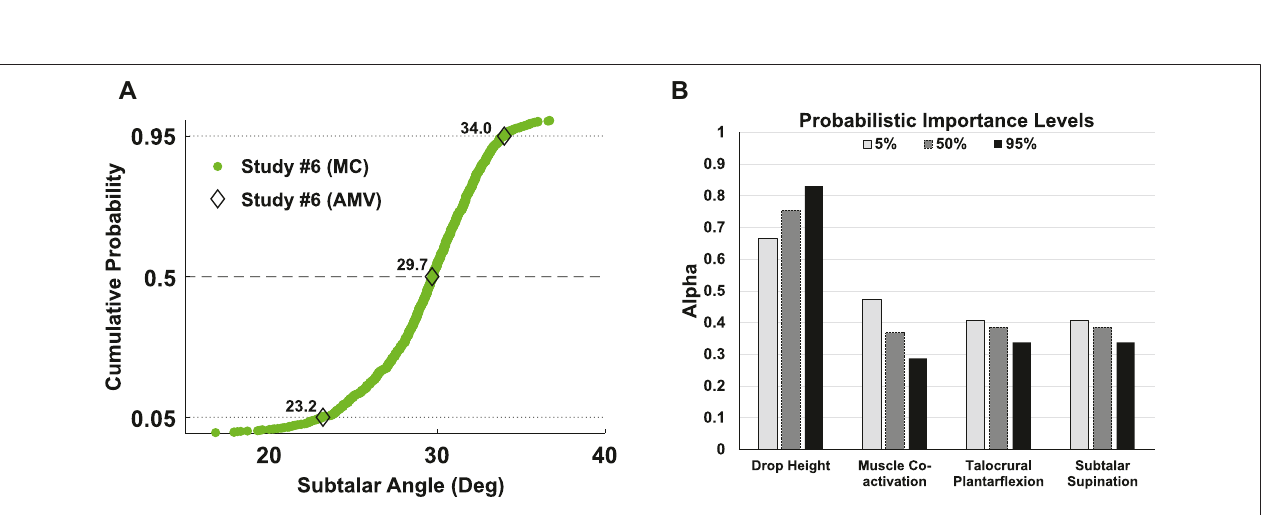
FIGURE 5 | (A) Advanced Mean Value (AMV) probabilistic method in comparison to traditional Monte Carlo (MC) for Study #6 ( Table 1 ). For 10 input parameters, the ef fi cient AMV method required only 14 model evaluations to predict response probabilities (0, 5, 50, 95%) which agreed with a 1000-trial MC. The AMV method executed in 4 min processing time versus 13 hours for MC (laptop, Intel i7 CPU). (B) Probabilistic Importance Levels computed using the AMV method. Alpha values at each probability level are the components of a unit vector pointing in the direction of the response gradient (steepest ascent). The root-mean-square sum of alpha valuesisunityandthusestablisharelativerankingofinputparameterstowhichtheresponseismostsensitive.ForexemplaryStudy#6,onlyfourof10inputparameters hadnon-zeroalphavalueswhichsuggestedthatdropheightwasthemostin fl uential,andshowedincreasingin fl uencebetween5and95%responselevels,followedby talocrural/subtalar joint postures and muscle co-activation, the latter of which showed decreasing in fl uence between 5 and 95% response levels.